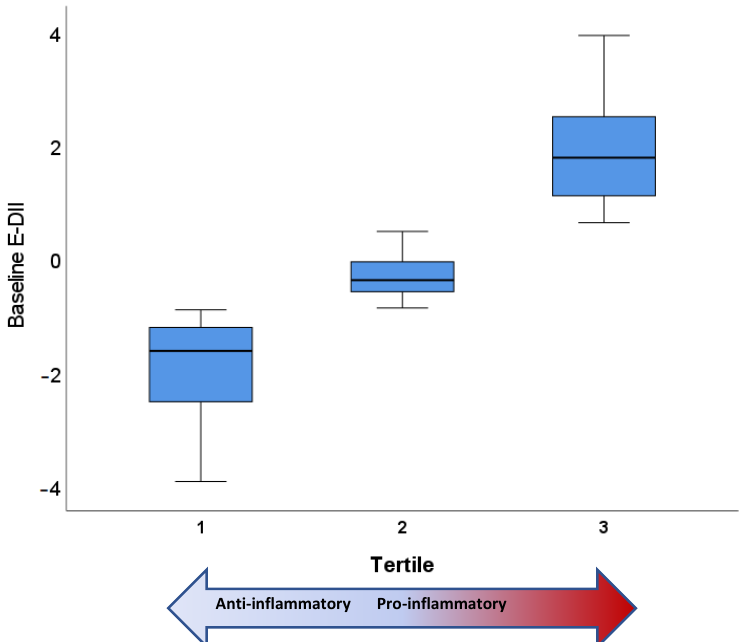
Figure 2. Baseline dietary inflammatory index (adjusted for energy intake) stratified into tertiles. Tertile 1 represents the lowest E-DII, being the most anti-inflammatory, while tertile 3 represents the highest E-DII, being the most pro-inflammatory.